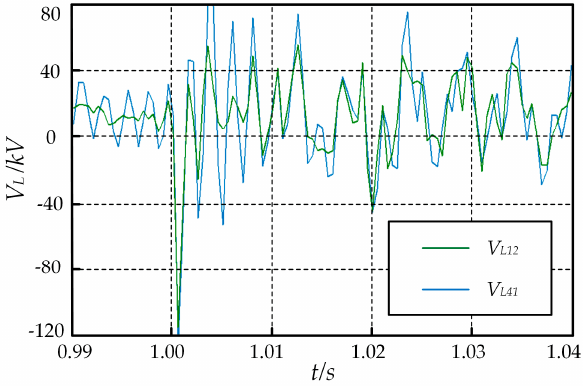
Figure 17. V L12 and V L41 during AC side faults.